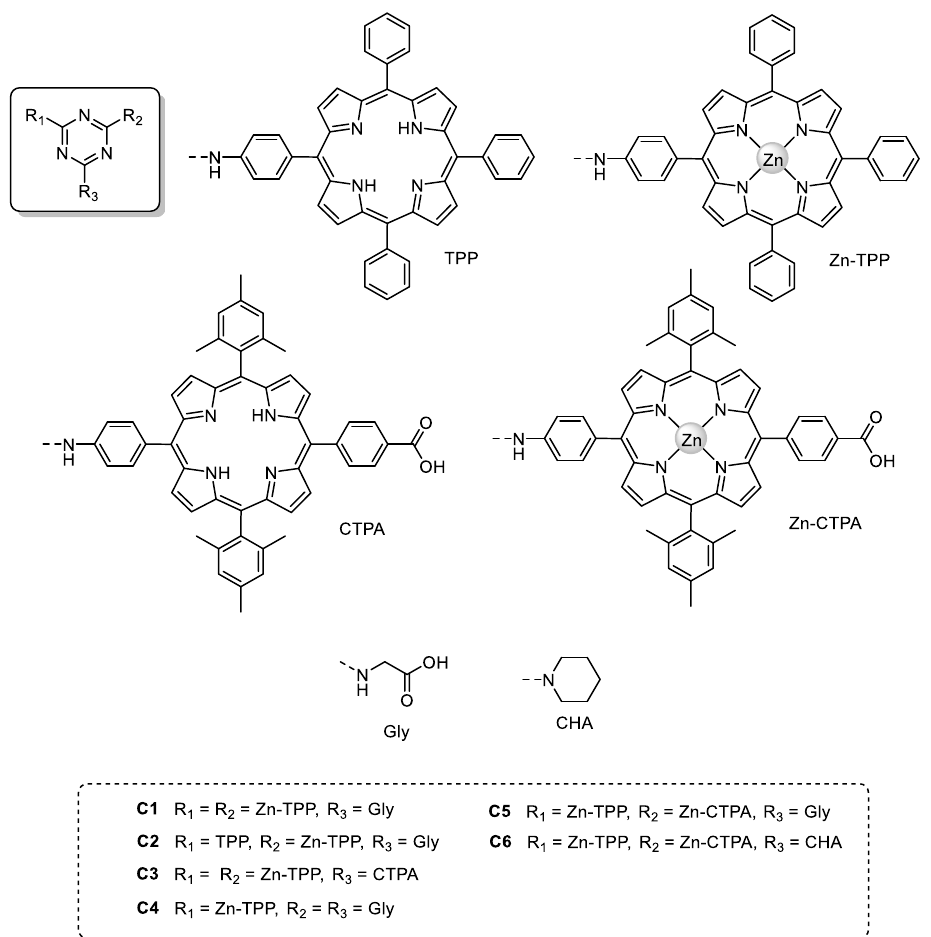
Figure 8. Structures of Zn-metalated porphyrin-based triazine photosensitizers employed in DSSCs. Table 2. Optoelectronic properties and performance characteristics of metal-free triazine-based